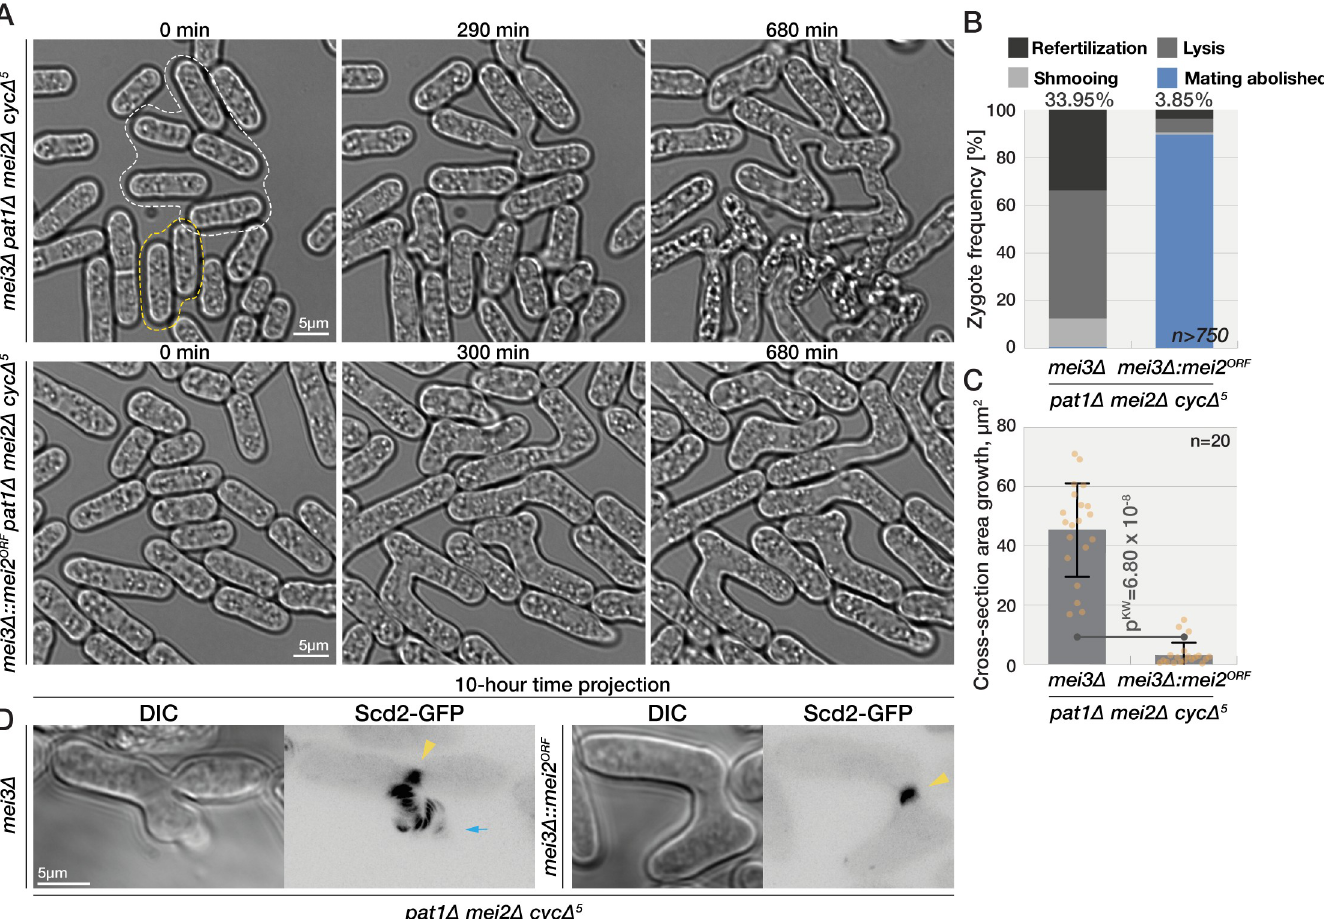
Fig 7. Mei2 blocks zygotic mating independently of cell cycle progression. (A) Mating mixtures of SMS cyc Δ 5 cells (bottom), which induce Mei2 postfertilization and control cells that lack Mei2 (top). Mei2 expression prevents zygote lysis (yellow outlines) and refertilization (white outlines). (B) Quantification of phenotypes in zygotes as in (A). (C) Quantification of growth in zygotes as in (A) in the 10 hours after concave neck expansion was completed. Dots show individual measurements, bars mean values, and error bars standard deviation. p -Values for indicated comparisons were obtained from the Kruskal–Wallis test. (D) Projection of 60 time points during 10 hours from the time of fertilization of polarity and growth marker Scd2-GFP. The yellow arrowheads point to the signal at the neck. Scd2 is restricted to the neck in the zygote expressing Mei2 (right) but continuously trails the growth projection in the zygotes lacking Mei2 (blue arrow). The data underlying this Figure may be found